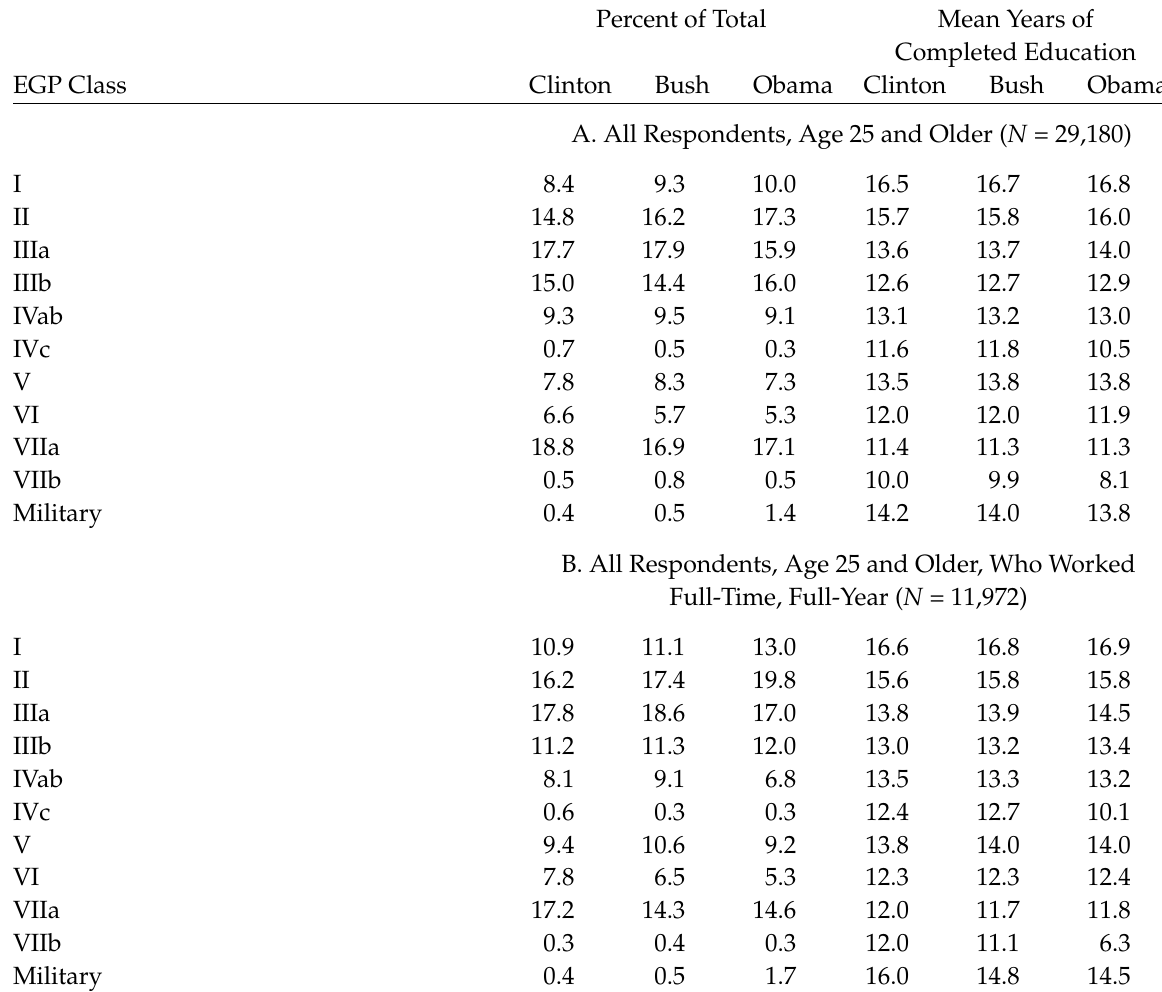
Table 2: The distribution of social classes across three presidencies, with average levels of education. Percent of Total Mean Years